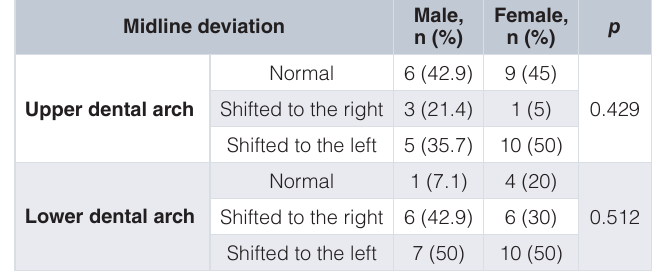
Table 4. Difference of midline deviation based on gender in condylar hyperplasia patients.